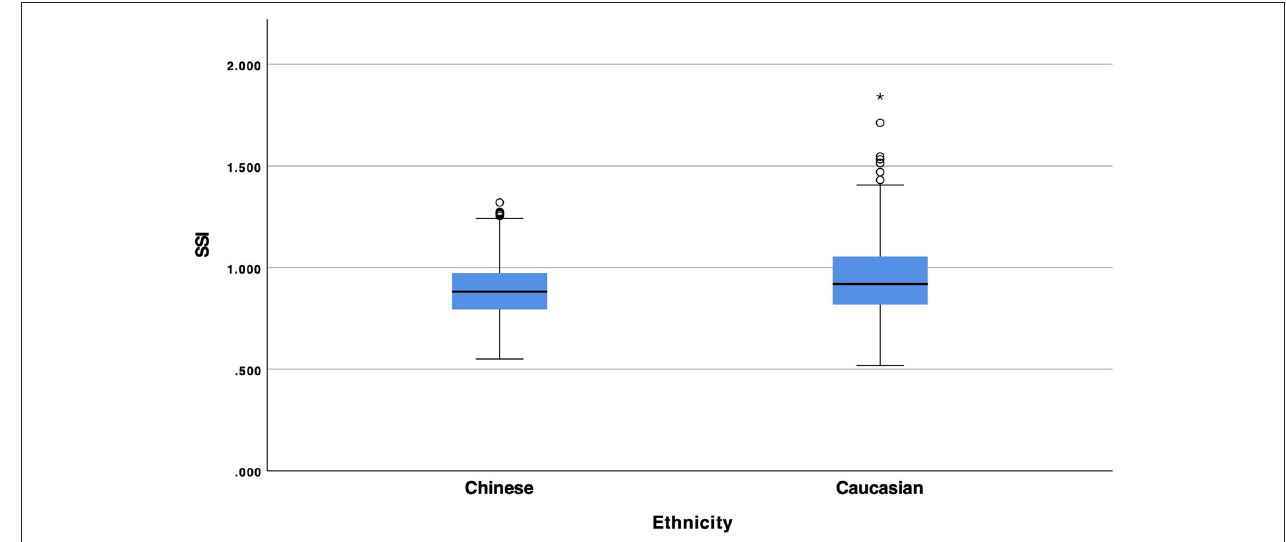
FIGURE 3 | Box and whiskers plot of SSI of Chinese and Caucasian population.